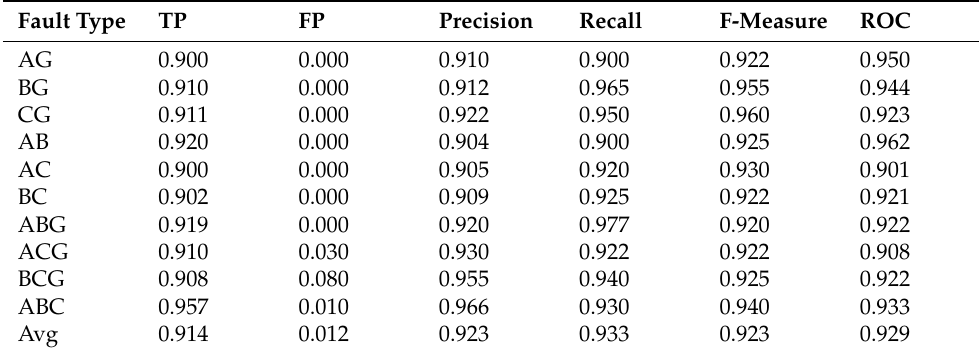
Table 16. SVM classification with a single cycle post-fault with PV and WE sources. Fault Type